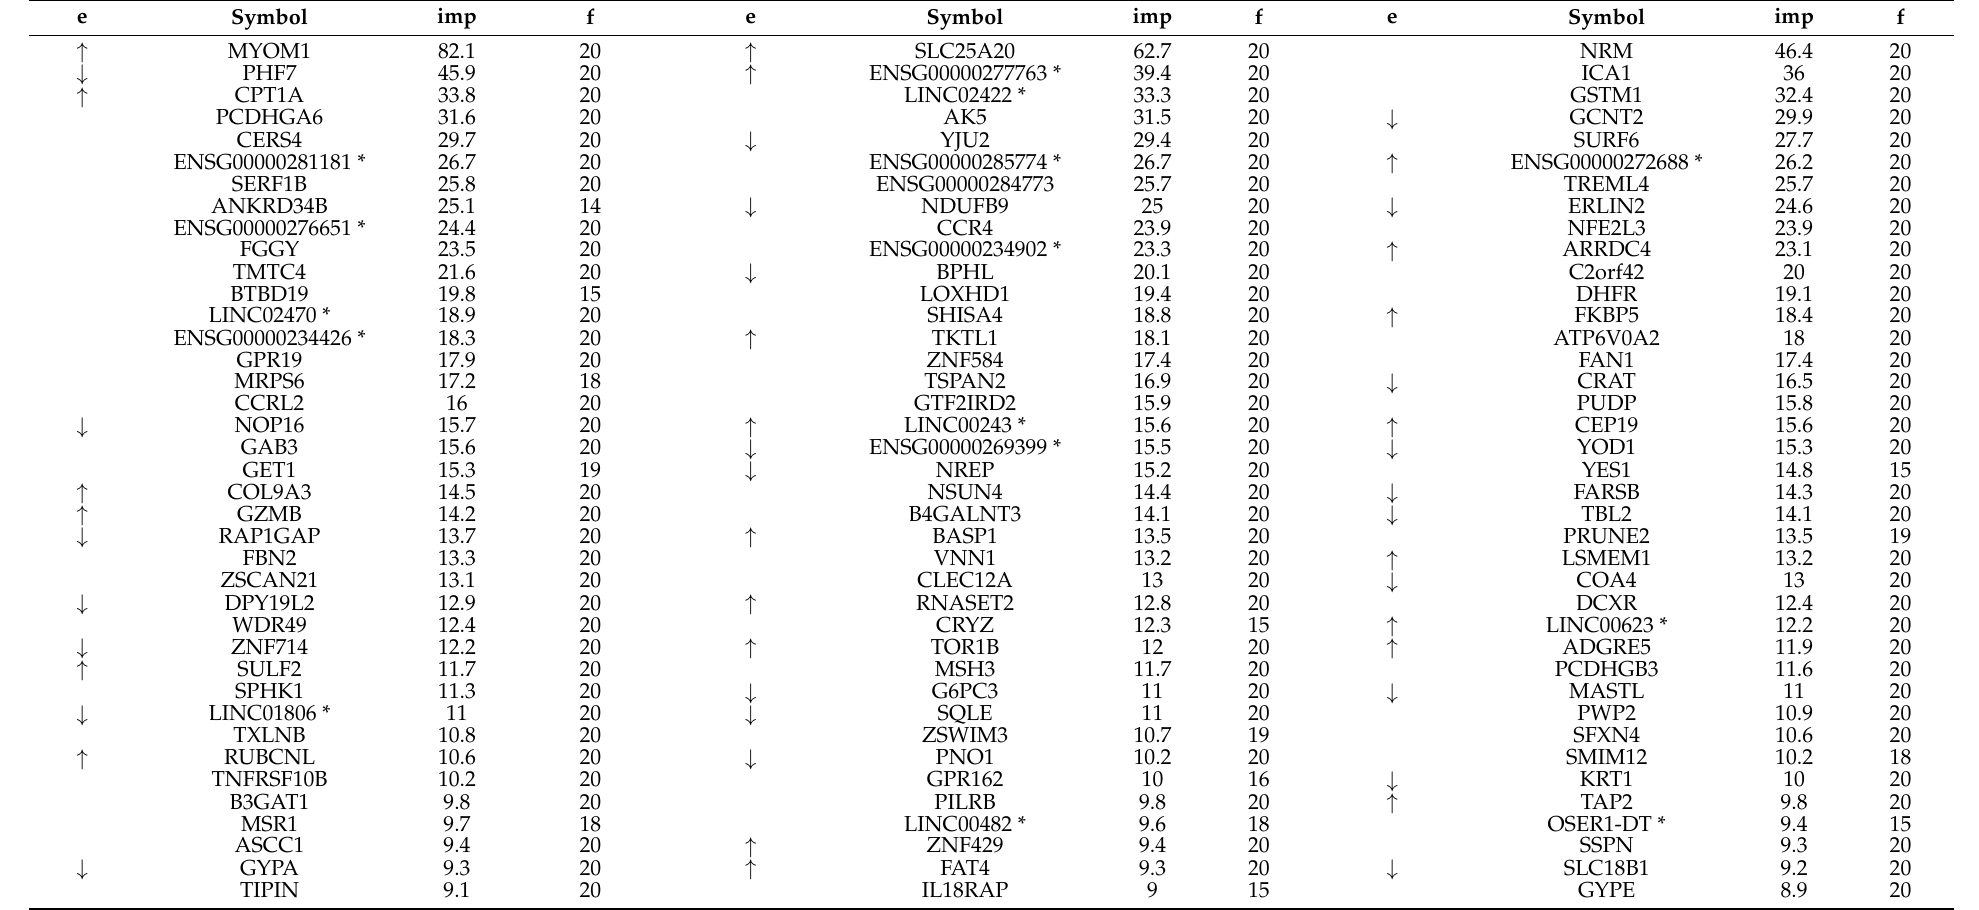
Table A1. Complete list of the most frequent protein coding genes and lincRNAs, ordered by importance. LincRNAs are marked with an asterisk. For each gene, four attributes are listed: (i) No arrow, an upward pointing arrow, a downward pointing arrow indicate no significant DE bewteen PD and HC, significant over-expression in PD subjects, significant under-expression in PD subjects, respectively; (ii) HGCN symbol (or Ensembl ID when missing); (iii) Average importance over 20 runs of 5-fold cross validation; (iv) Frequency of occurrence over 20